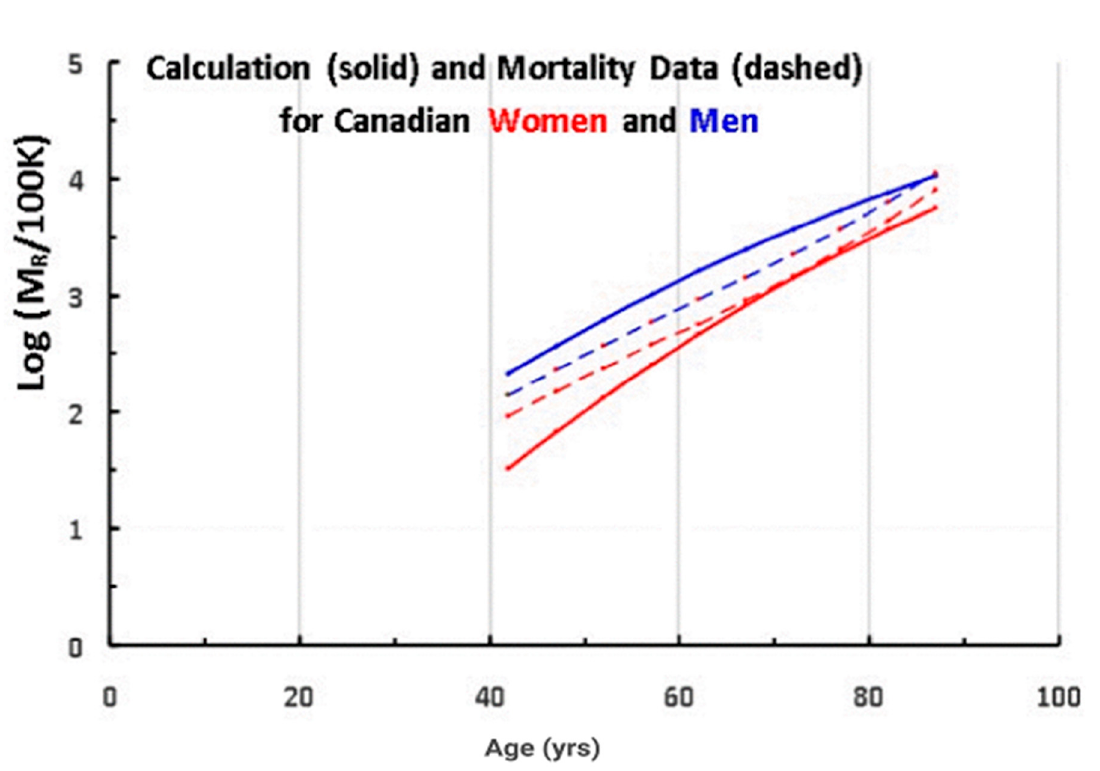
Figure 5. The log of the mortality rate (per 100 K) vs. age for men (red) and women. (blue), comparing the calculated data (solid lines) with actual data (dashed lines) for Canadians (2013).